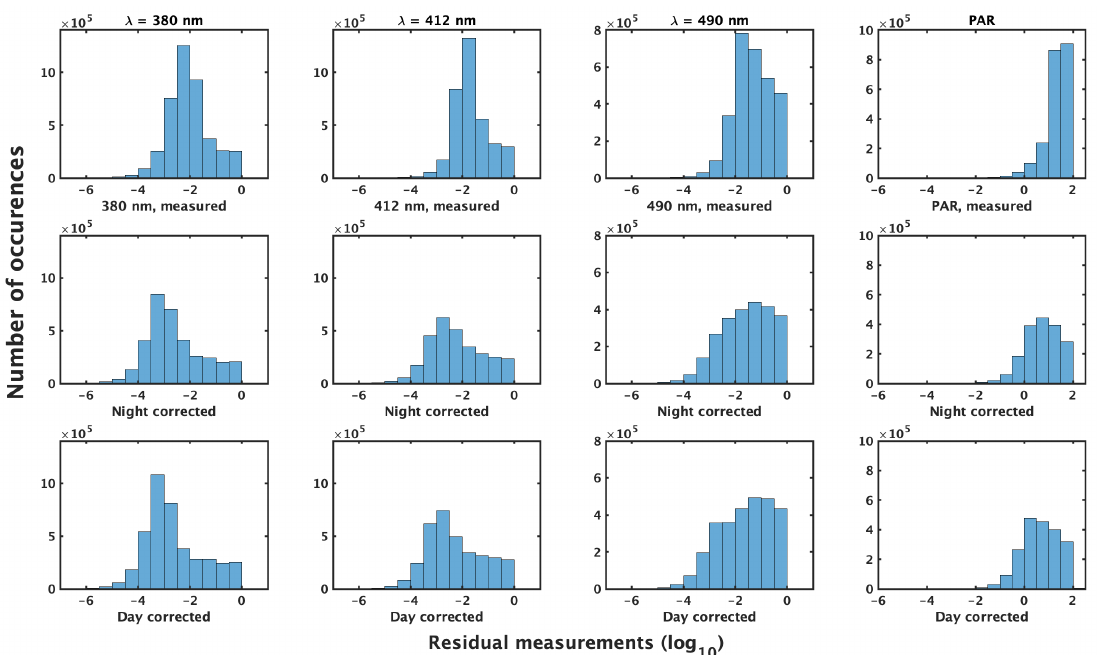
Figure 6. Measurements of E d ( λ , z) < 1 W m − 2 nm − 1 and PAR(z) < 100 µ mol photons m − 2 s − 1 ( top row) after corrections are applied by the night method ( middle row) and day ( bottom row). Columns are ( left to right ) λ = 380, 412, 490 nm and PAR. Plotted on log 10 scale.